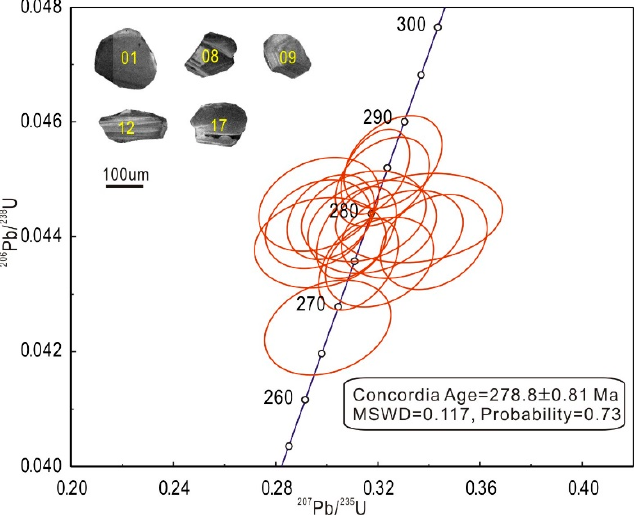
Figure 4. Representative cathodoluminescence (CL) images and U–Pb concordia diagram of zircons from sample RB25.